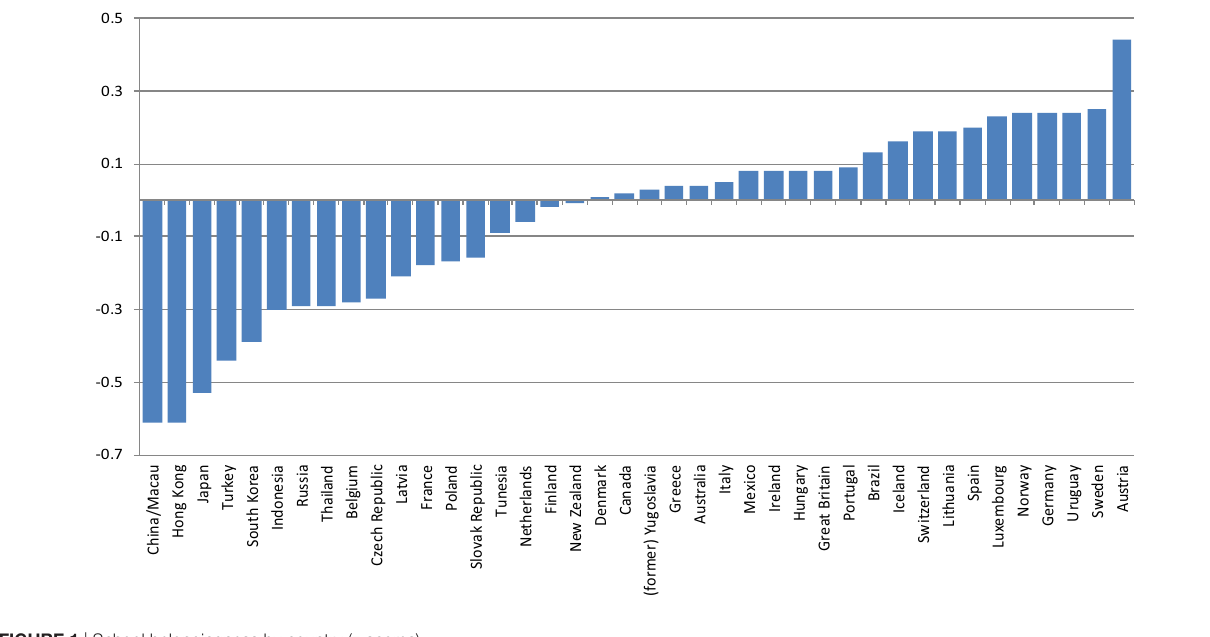
FigUre 1 | School belongingness by country ( z